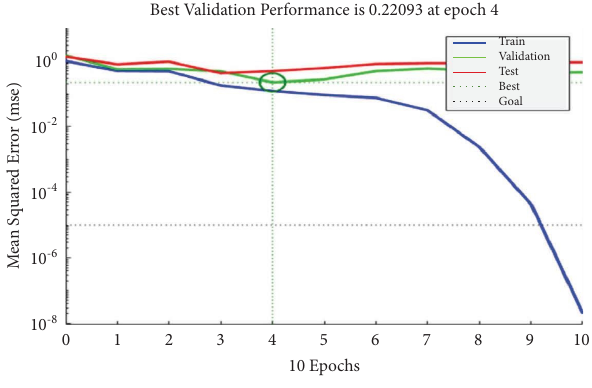
Figure 5: Network